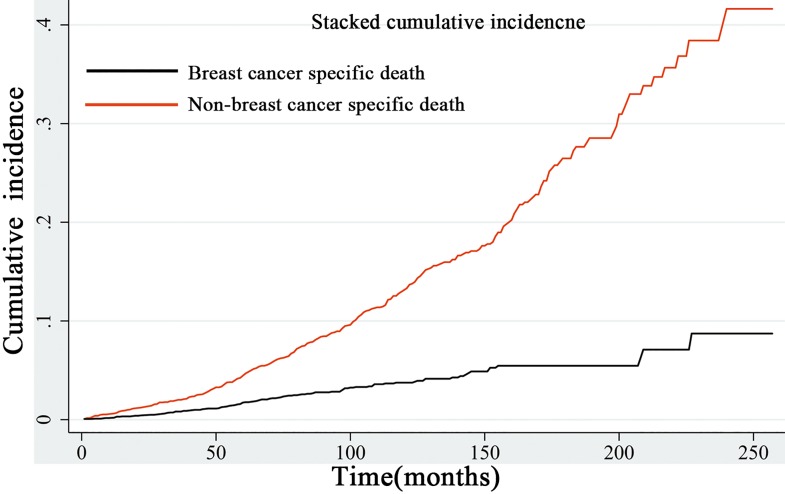
Stacked cumulative incidence plot of breast cancer-specific survival and non-breast cancer-specific survival.Non-breast cancer specific survival had a predominant impact on the survival.